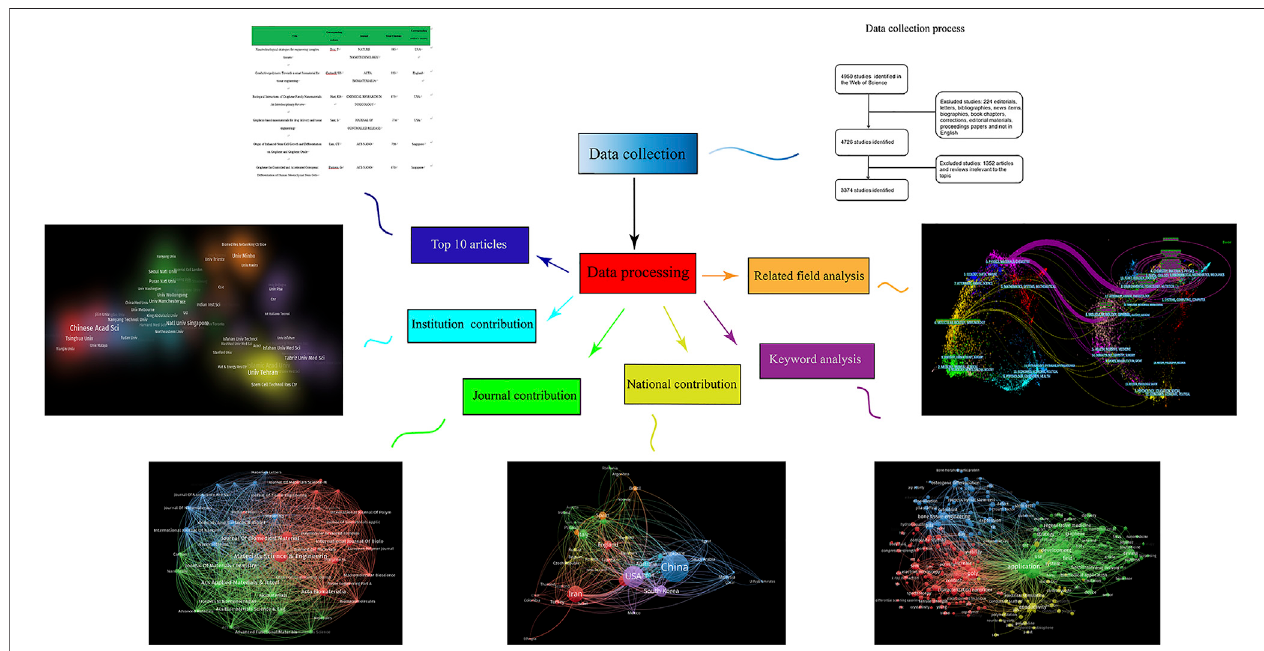
FIGURE 3 | Flow diagram of six aspects of electroactive biomaterials used in tissue engineering. Contributions of countries, contributions of different journals and top 10 articles, contributions of different institutions, keywords, and related fi elds are listed.